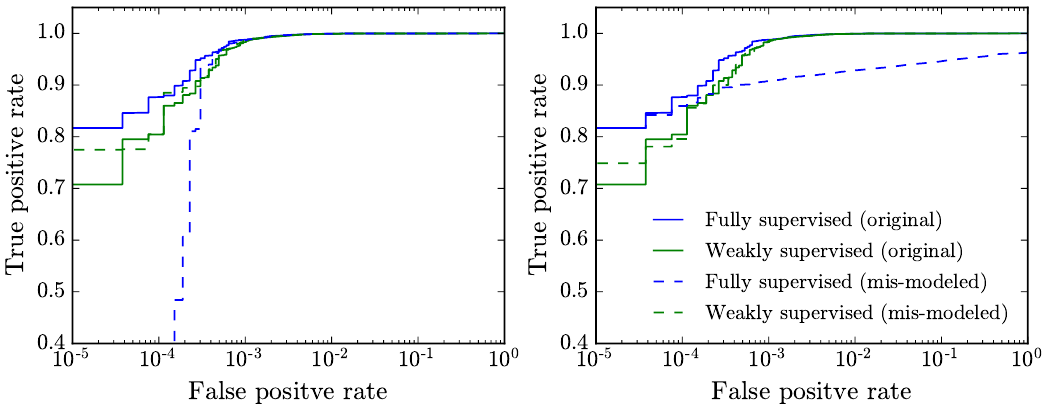
Figure 10 . ROC curves showing the response of the network to mismodeled data. The mismodeling in the left panel shows the results of taking a random 15 % of the signal events and labeling them as background before training. The right panel demonstrates what happens under a phase space swap, where we mislabel the 10 % most signal-like background event and the 15 % most background-like signal events. The fully supervised network trained on the mislabeled data performs much worse at small false positive rates than when the data is not mislabeled. The weakly supervised network does not rely on individual event labels, and therefore has essentially no change in